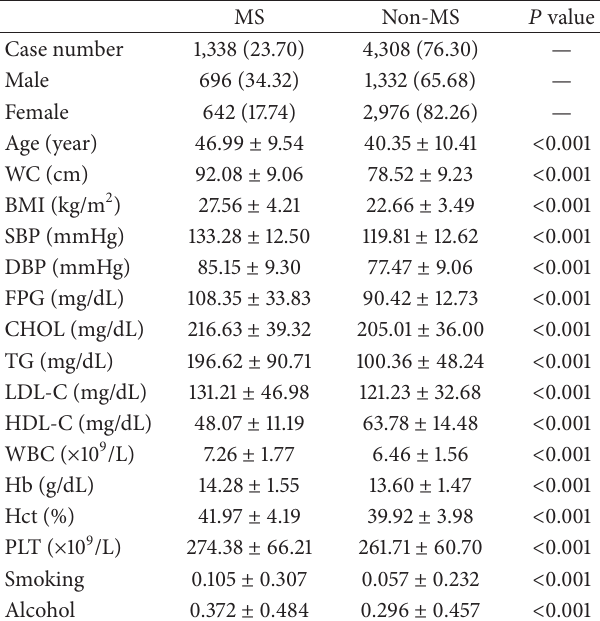
Table 1: Comparison of clinical and biochemical parameters between MS and non-MS